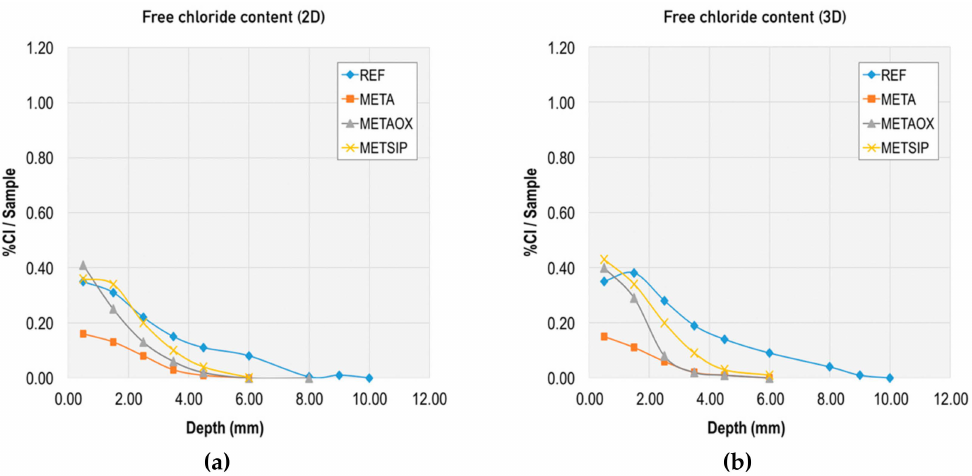
Figure 11. Free chloride content in di ff erent mixes at early ages: ( a ) at two days and ( b ) at three